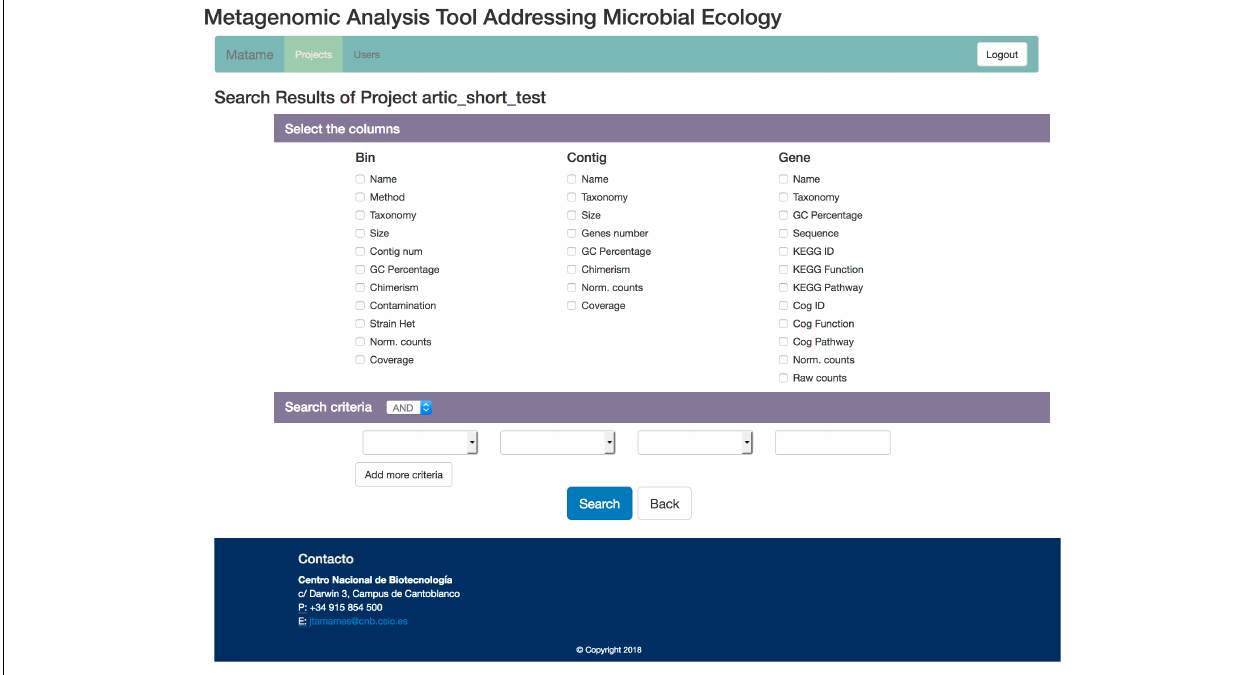
FIGURE 2 | Snapshot of the SqueezeMeta user interface to its database. A flexible and intuitive system for building queries allows interrogating the database with complex questions involving combination of data from different tables.